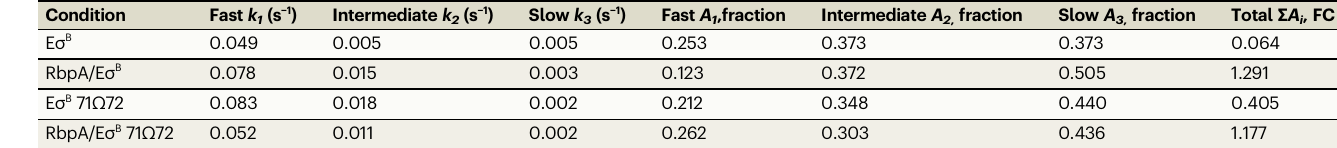
Table 2 | Kinetic constants of RPo formation on the sigA Pext-10(+2Cy3) promoter Condition Fast k 1 (s − 1 )